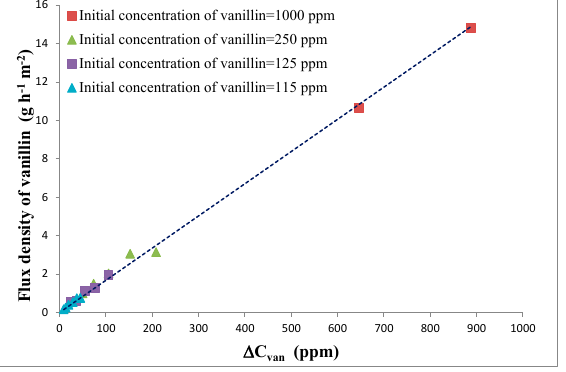
Figure 3. Permeate flux density of vanillin vs. the driving force ∆ C van . T = 60 ◦ C, Ph ≈ 5.5, upstream flow rate of Liquid 1 through the module = 115 L / h (Re 1 = 1600), and downstream flow rate of Liquid 2 through the module = 72 L / h (Re 2 = 1020).